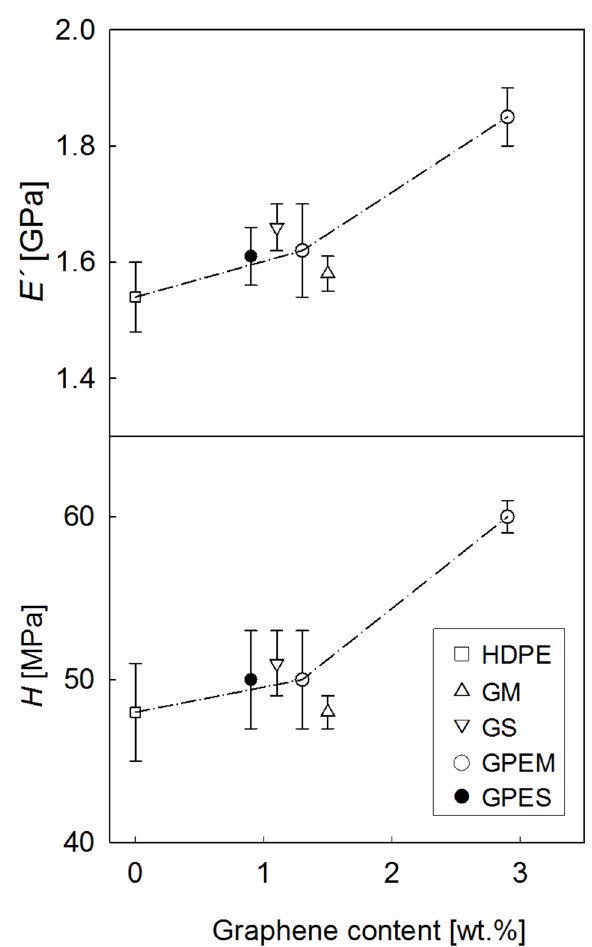
Figure 5. Storage modulus, E (cid:48) and hardness, H , as a function of graphene content (neat graphene, i.e., excluding the polymer brushes) for all the nanocomposites and the starting HDPE: GM, neat graphene and melt extruded; GS, neat graphene and solution mixed; GPEM, modified graphene and melt extruded; GPES, modified graphene and solution mixed. The dashed lines are guides for the eyes. Table 2. E (cid:48) and H derived from instrumented indentation at a penetration depth of 2 µ m. Sample E (cid:48) (GPa)